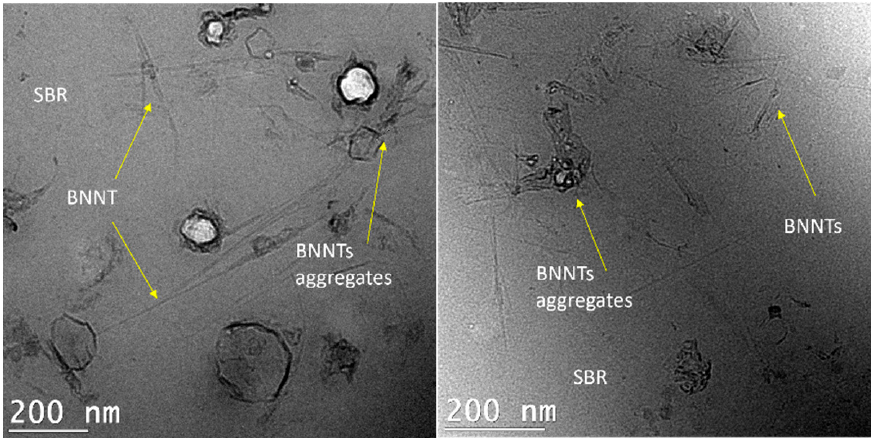
Figure 6. TEM images of SBR/BNNTs nanocomposites at 1 wt%.